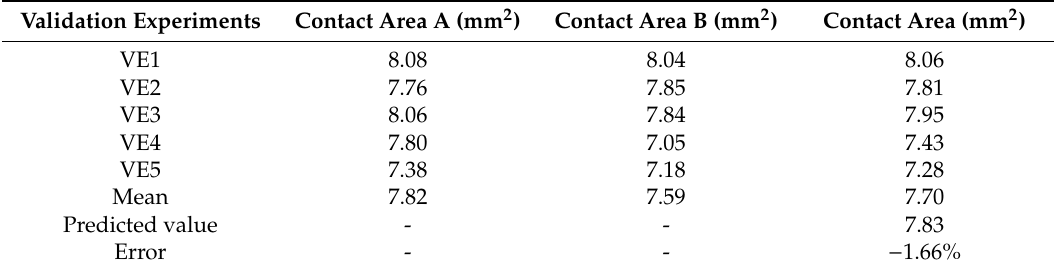
Table 8. Validation experiments.